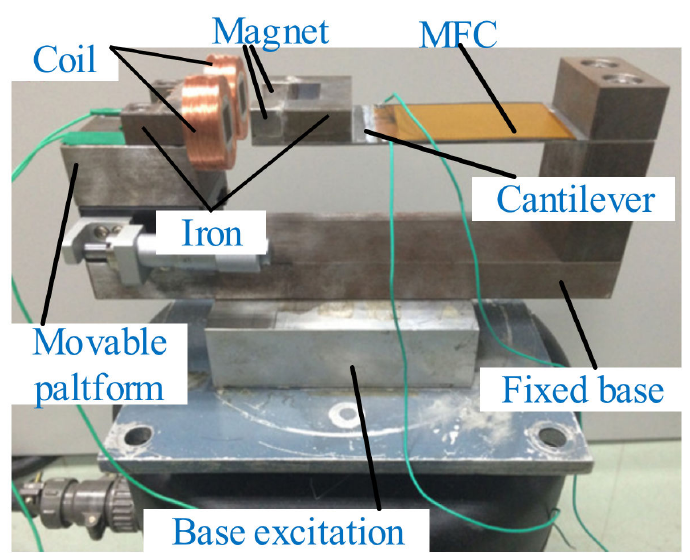
Figure 19. Representative designs with two electromagnetic units (reproduced with permission from [217]; published by Elsevier B.V.,